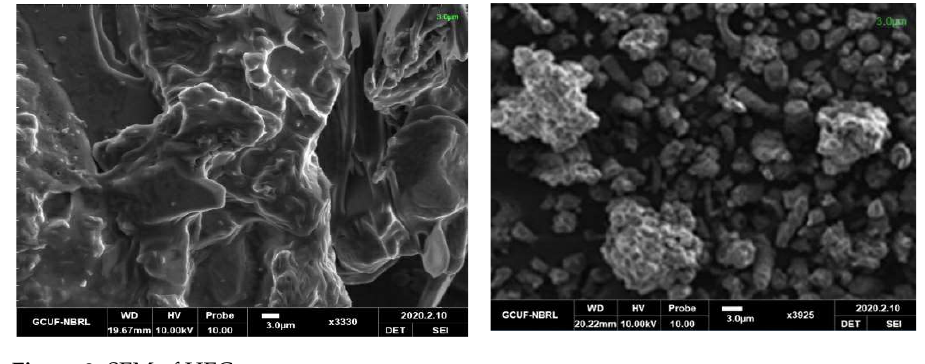
Figure 9. SEM of HEC.